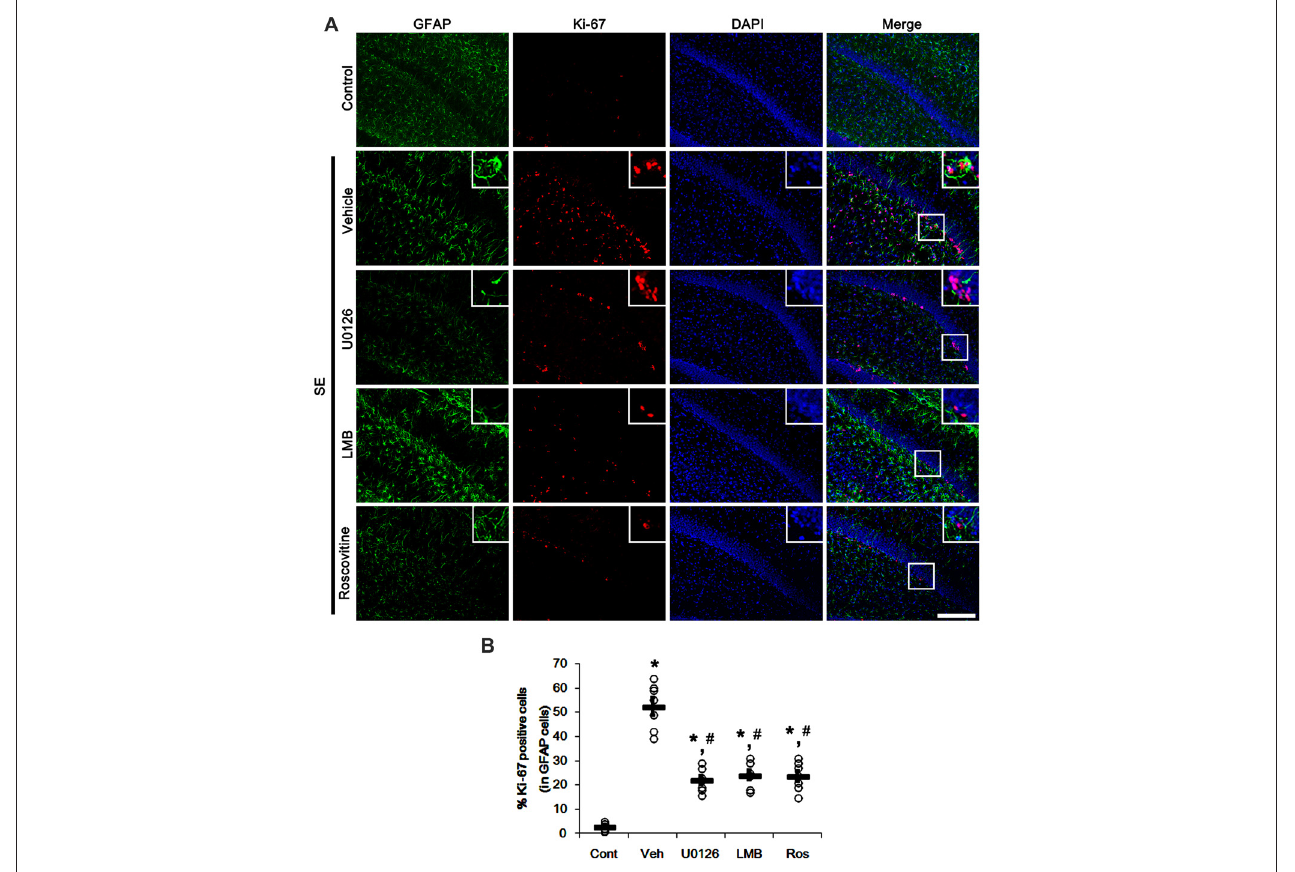
FIGURE 6 | Effects of U0126, LMB and roscovitine on Ki-67 expression in the dentate gyrus following SE. (A) Representative double immunofluorescent images for Ki-67 positive astrocytes. SE increases nuclear Ki-67 expression in astrocytes within the subgranular zone and the hilus. As compared to vehicle, three distinct compounds reduce the number of Ki-67 positive astrocytes. Insert images are high magnification of rectangles in merge panels. Bar = 100 and 25 (inserts) µ m. (B) Quantifications of the number of Ki-67 positive astrocytes. Open circles indicate each individual value. Horizontal bars indicate mean value. Error bars indicate SEM ( ∗ , # p < 0.05 vs. control and vehicle, respectively; n = 7,